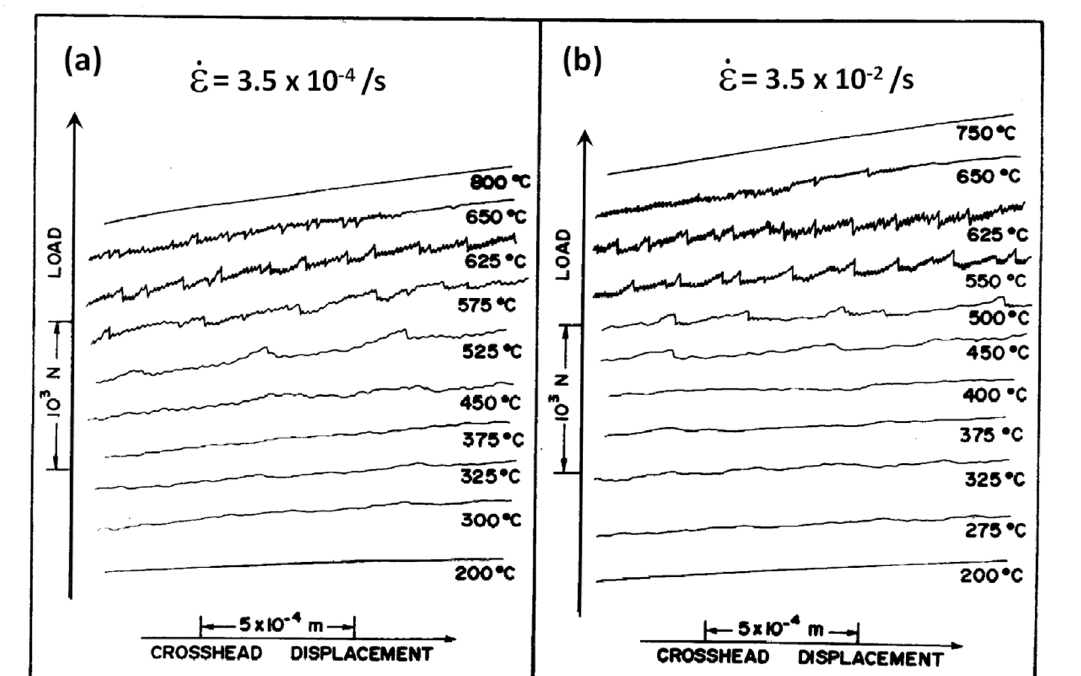
Figure 1. Partial load vs elongation flow curves for AISI 304 steel tensile tested at different strain rates: (a) 3.5 x 10 -4 s -1 and (b) 3.5 x 10 -2 s -1